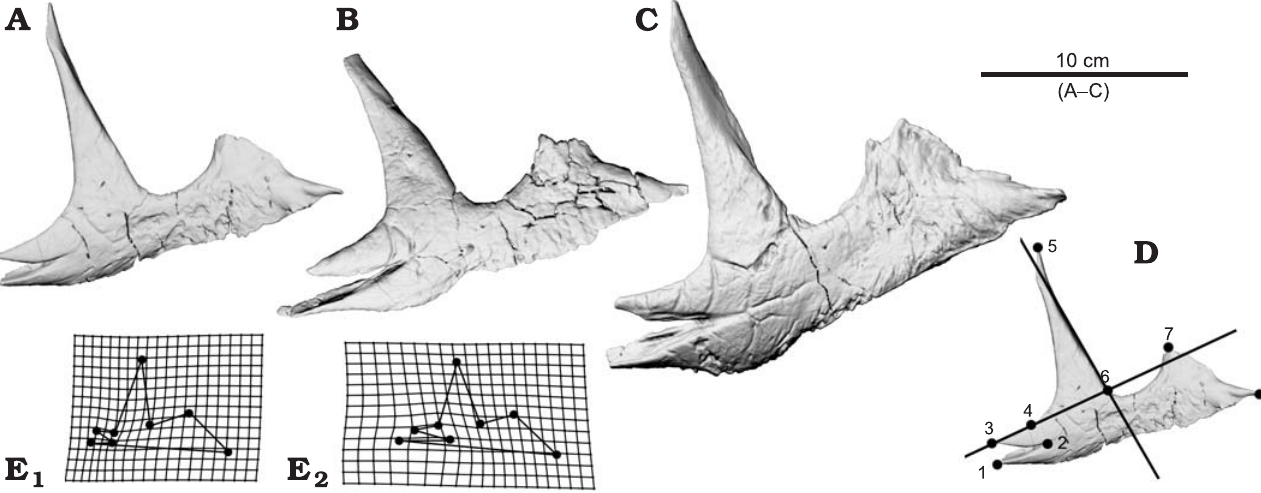
Fig. 7. Representative jugals (rendered CT images) of Majungasaurus crenatissimus (Depéret, 1896) Lavocat, 1955 from the Maastrichtian (Upper Cretaceous) Maevarano Formation, northwestern Madagascar in right lateral view. A . UA 9944. B . FMNH PR 3369. C . FMNH PR 2100. D . Illustration of landmark positions used for jugals. Black circles, landmarks. E . Ontogenetic shape change visualized by deformation grids relative to average; outline of smallest (E 1 ) and largest (E 2 ) specimens from